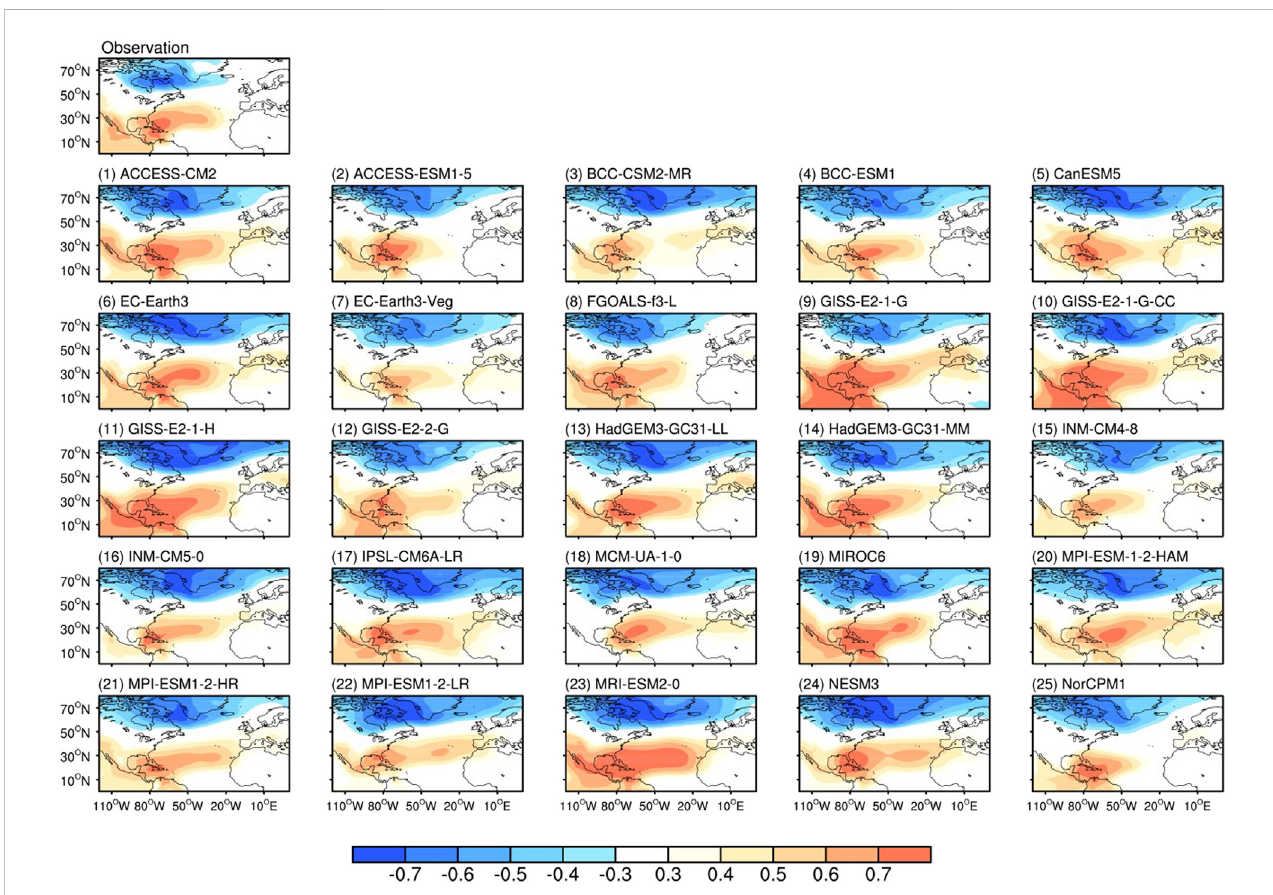
FIGURE 9 Spatial pattern of DJFM-averaged SLP anomalies correlated with the concurrent NADI derived from observation and the 25 CMIP6 model